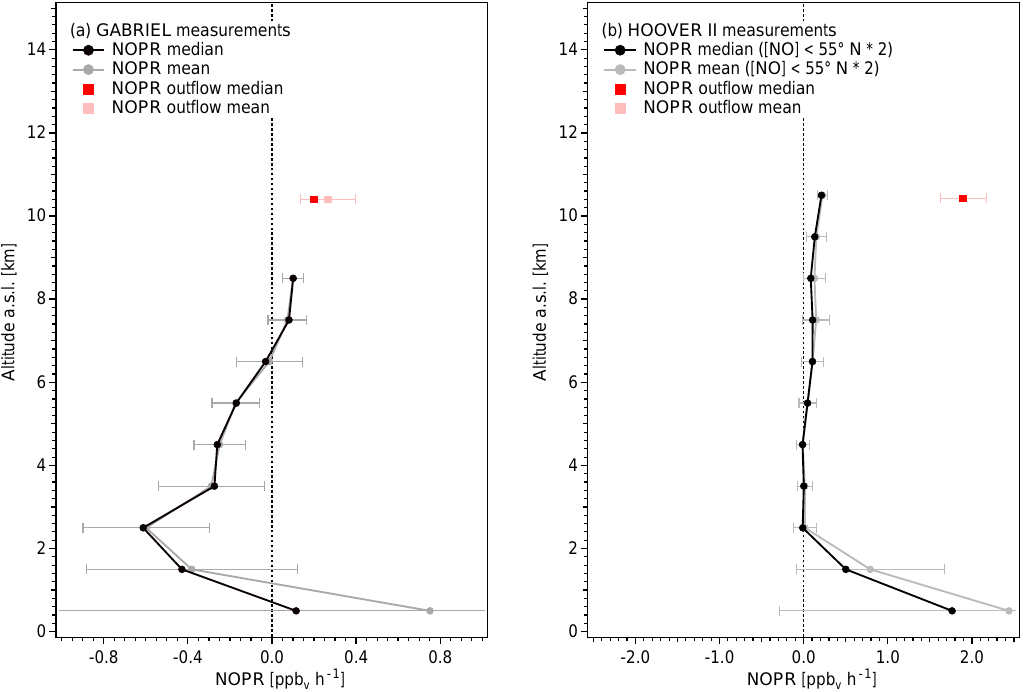
Figure 7. Net ozone production rates (NOPR) in ppbvh − 1 (red squares) calculated from in situ data for convective events during GABRIEL (a) and HOOVER II (b) relative to campaign average profiles